Question: Compose a caption that would accompany this figure in a paper.
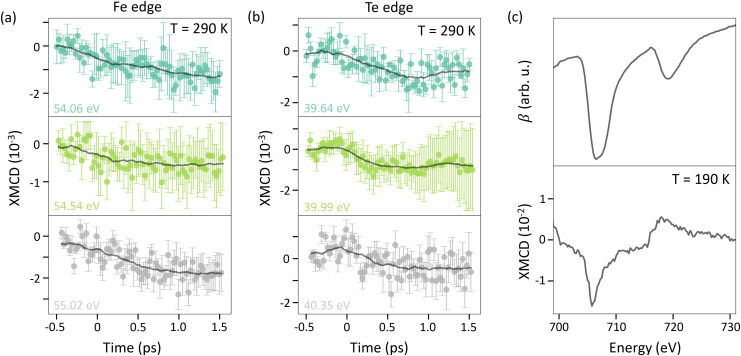
Answer: Time-resolved XMCD measurements at the (a) Fe M 2 , 3 and (b) Te N 4 , 5 edges at room temperature. The rolling mean of the XMCD is indicated by the black line as a guide to the eye. (c) Static absorption and XMCD at the Fe L 2 , 3 edges at 190 K , showing the ferromagnetic nature of the sample below Curie temperature.